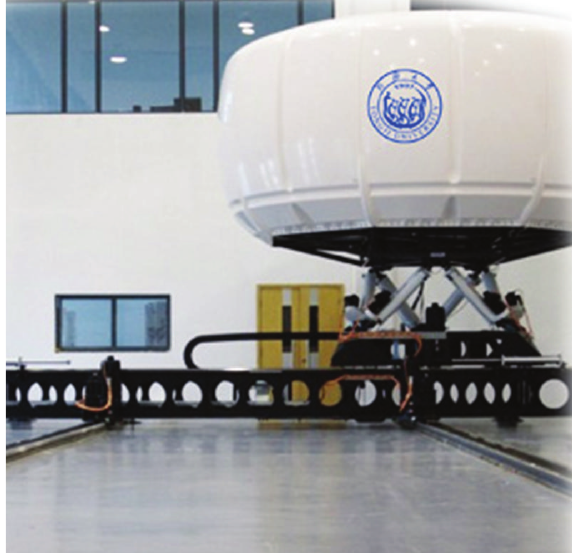
Figure 11: Driving simulator in Tongji University.